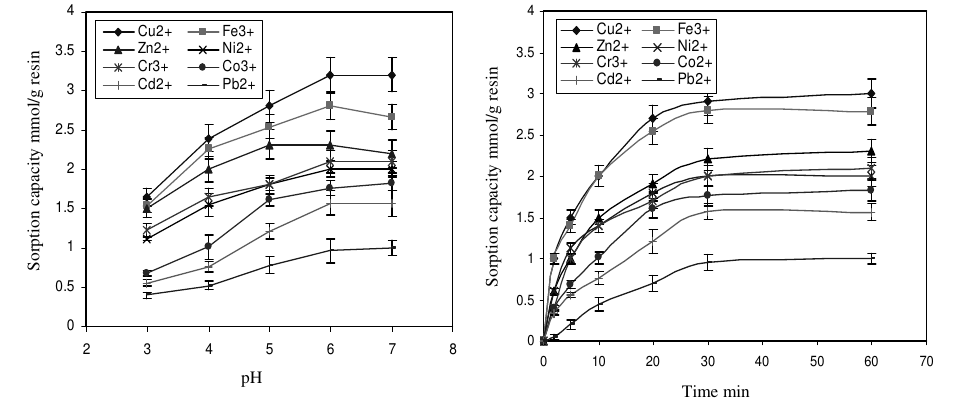
Figure 1 . Heavy metals sorption capacity by the ligands as a function of pH